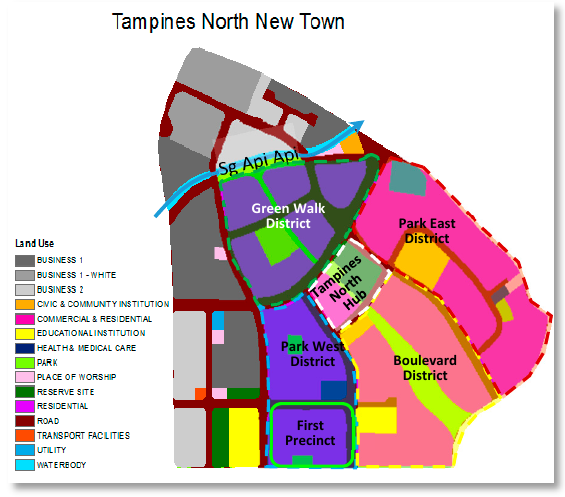
Figure 4. Proposed development of Tampines North New Town.